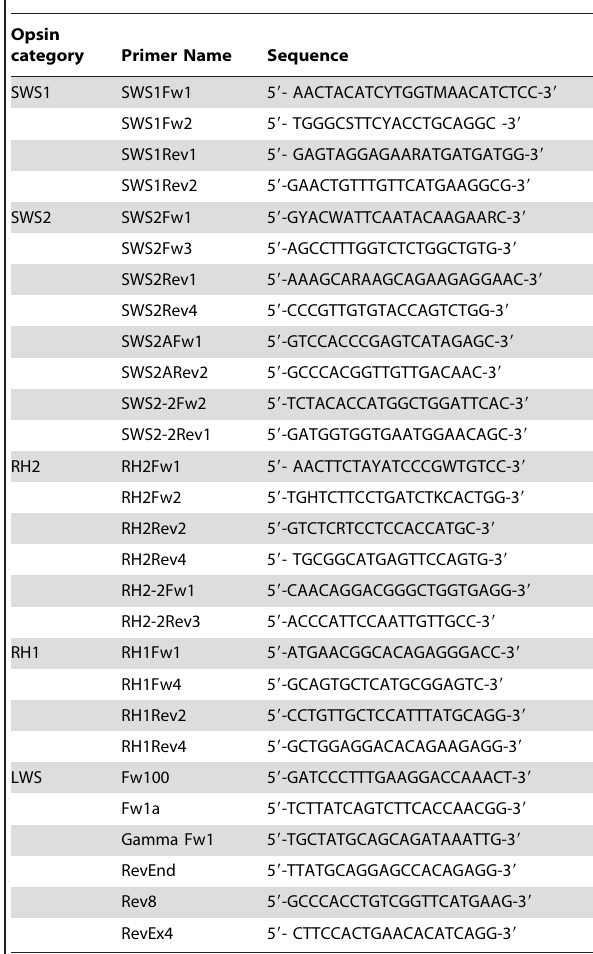
Table 1. Primers used for cDNA and genomic PCR and Southern blot probe